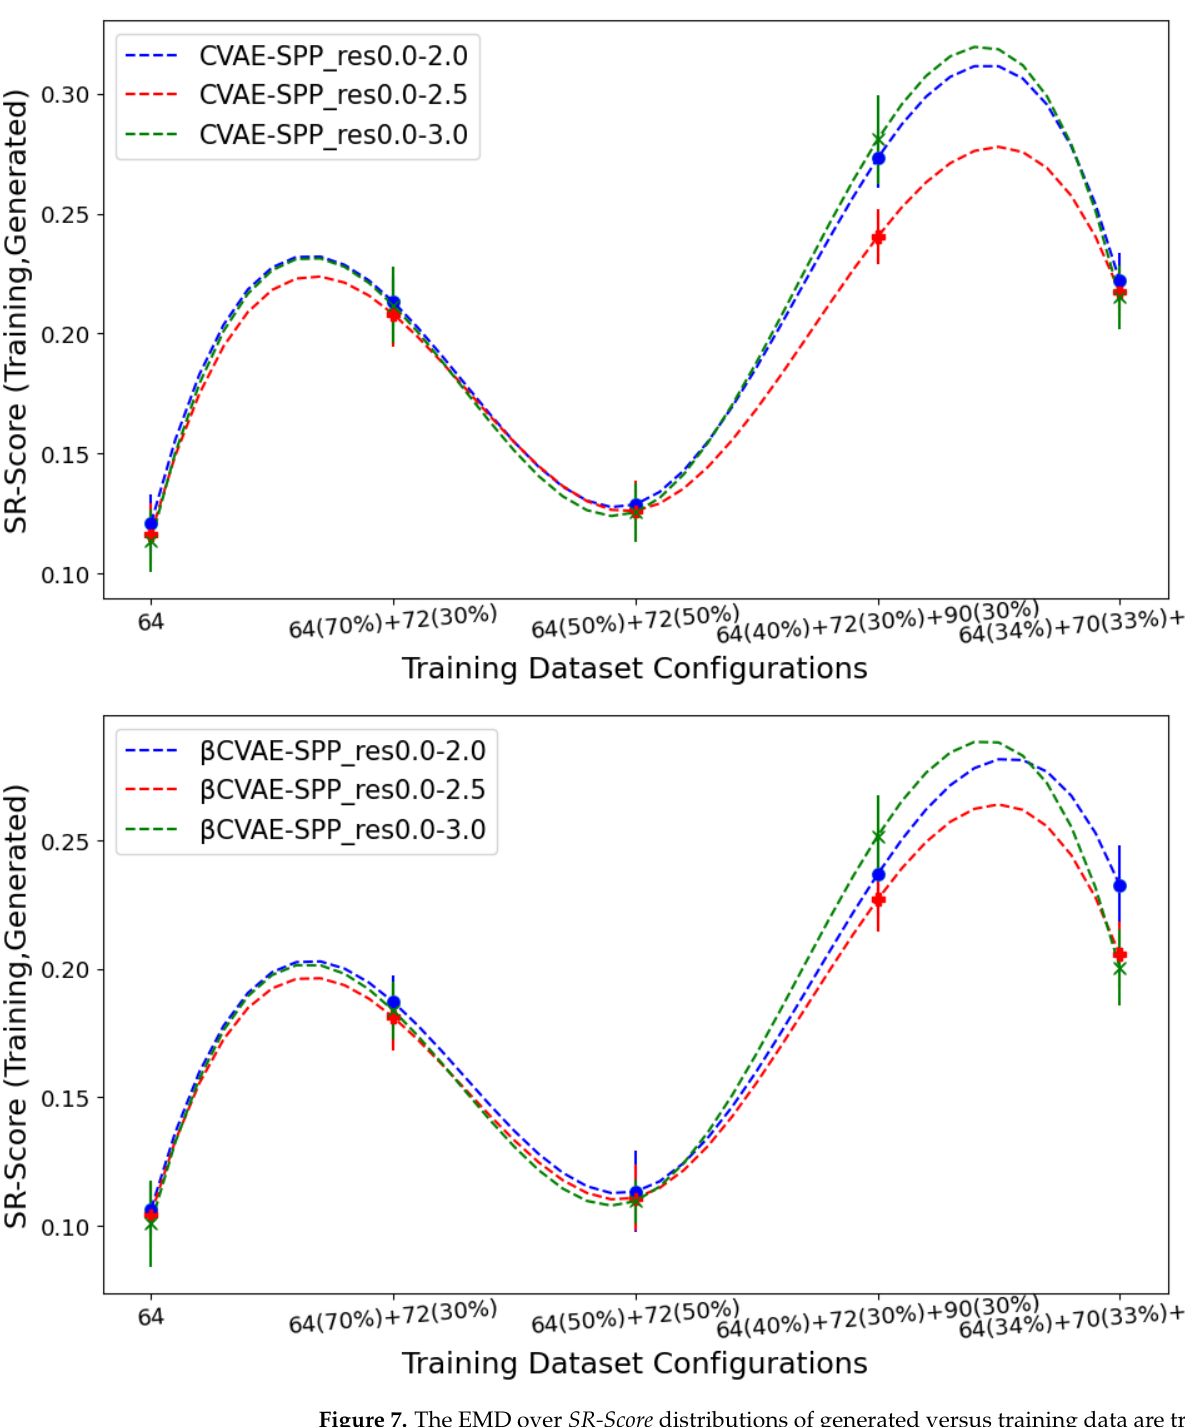
Figure 7. The EMD over SR-Score distributions of generated versus training data are tracked sepa- rately for CVAE-SPP (top panel) and β CVAE-SPP. In each panel, the comparison is made along the five training dataset configurations for each of the three input